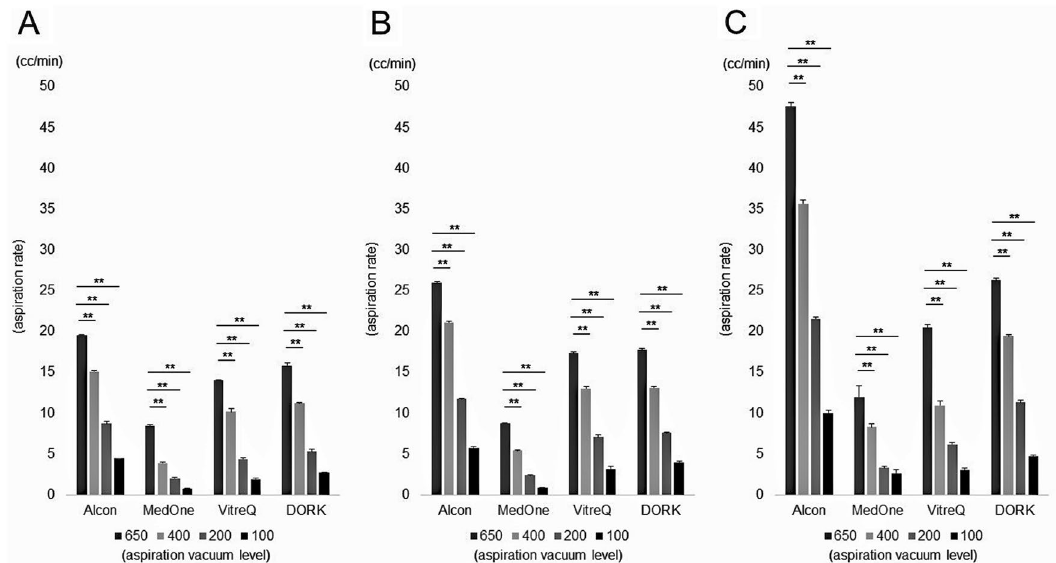
Figure 1. Comparison of aspiration rate (AR) under the condition of balanced salt solution aspiration. AR decreased significantly as the aspiration vacuum level decreased in each gauge of each company (** p < 0.01). ( A : 27G, B : 25G, C :